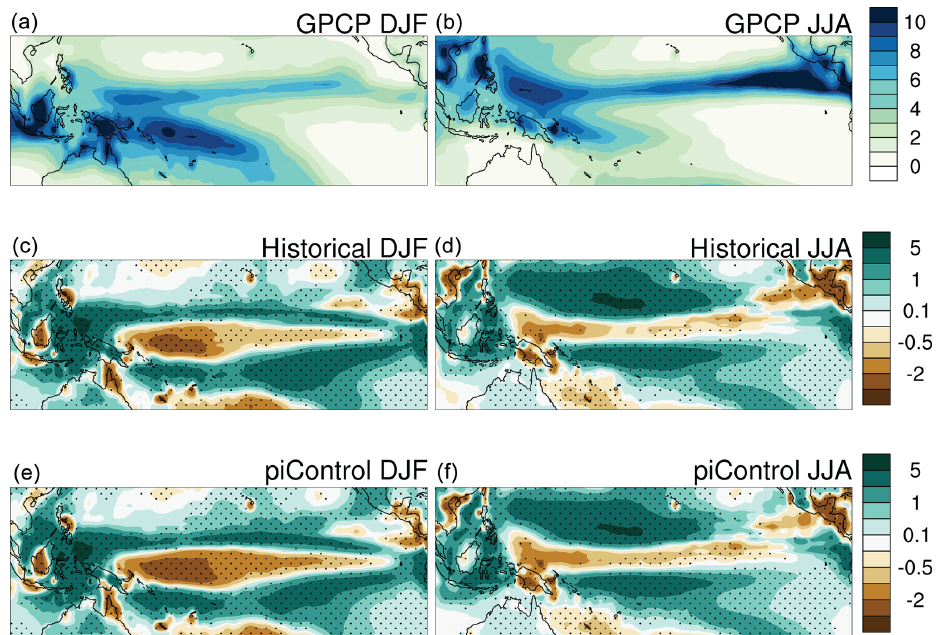
Figure 2. Ability of the ensemble to simulate present-day precipitation patterns: (a) DJF and (b) JJA SST climatology from the GPCP observational dataset (Adler et al., 2003) between 1979 and 1999, (c) DJF and (d) JJA model ensemble mean precipitation in historical simulations minus GPCP observations between 1979 and 1999, and (e) DJF and (f) JJA model ensemble mean precipitation in pre-industrial control simulations minus GPCP observations. Units are mmd − 1 . Stippling indicates that more than two-thirds of the ensemble members agree on the sign of the